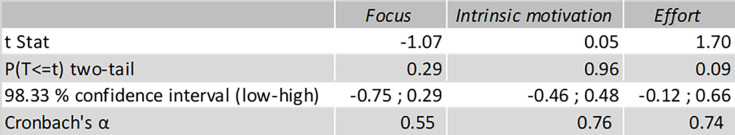
Focus, motivation and effort related to reward size.t-tests for equality of means, comparing high vs low rewarded sizes.